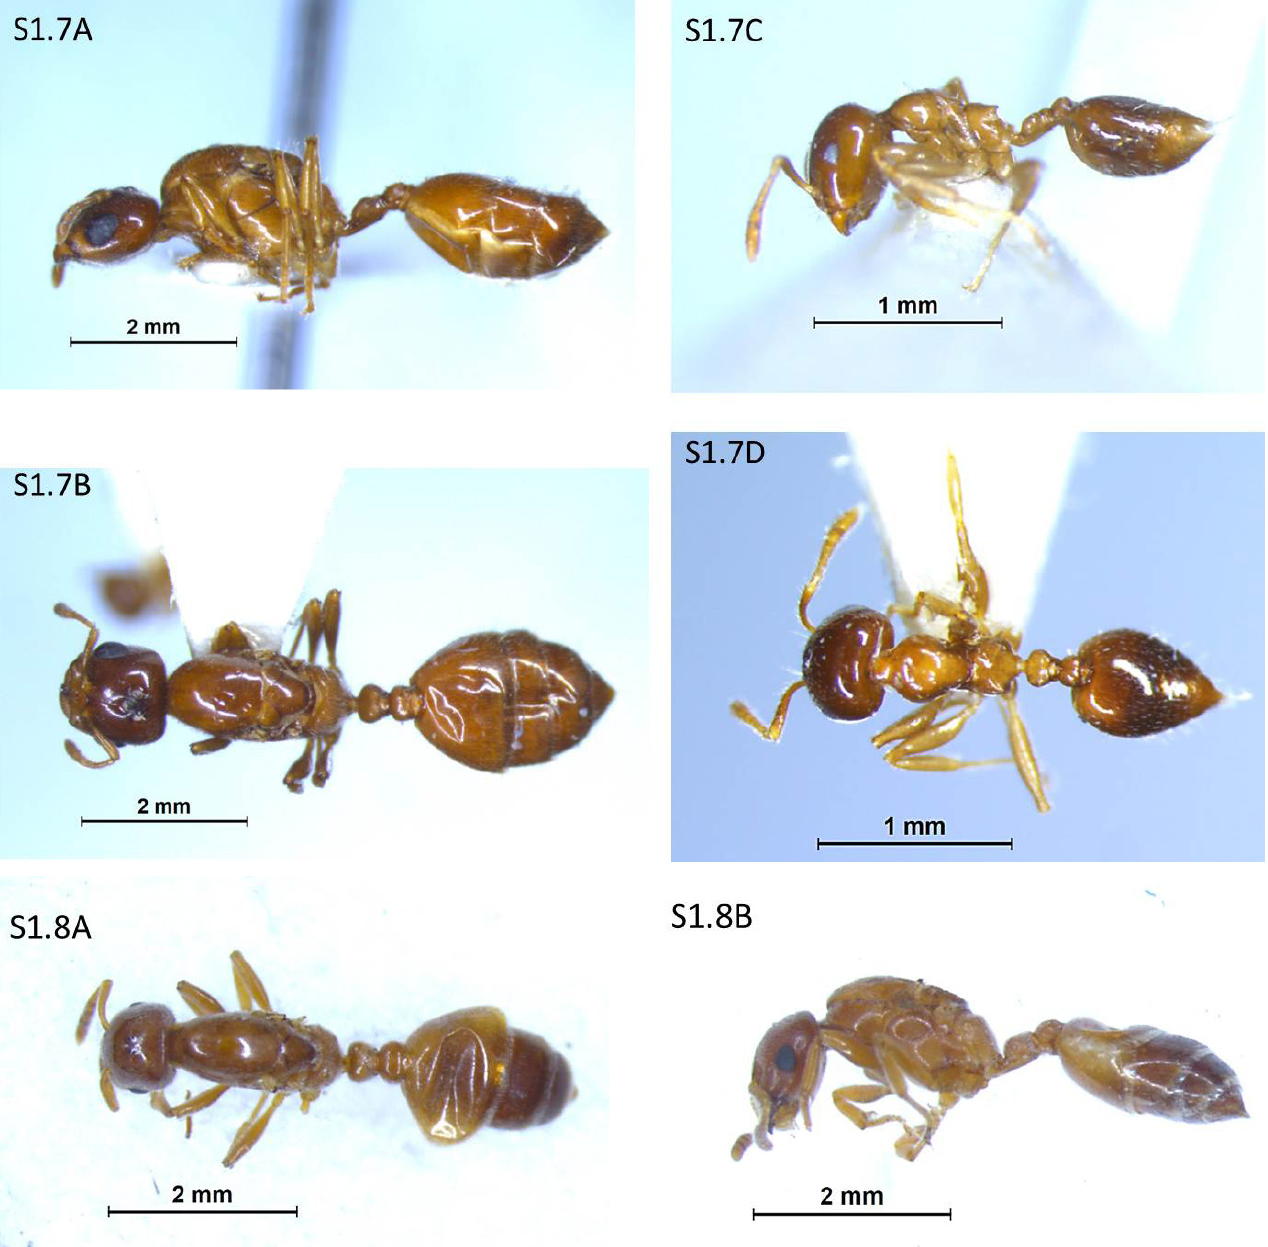
Fig S1.7A-D: C. claudiae, leg. H. Feldhaar, 6.10.2002, Bukit Tawau (Sabah) from Macaranga indistincta; S1.7A: lateral view queen, S1.7B dorsal view queen, S1.7C lateral view worker, S1.7D dorsal view worker. Fig S1.8: C. roslihashimi, leg. U. Maschwitz, 1.12.1996, Kuantan (Peninsula Malaysia) from Macaranga constricta; S1.8A: dorsal view of queen, S1.8B: lateral view of